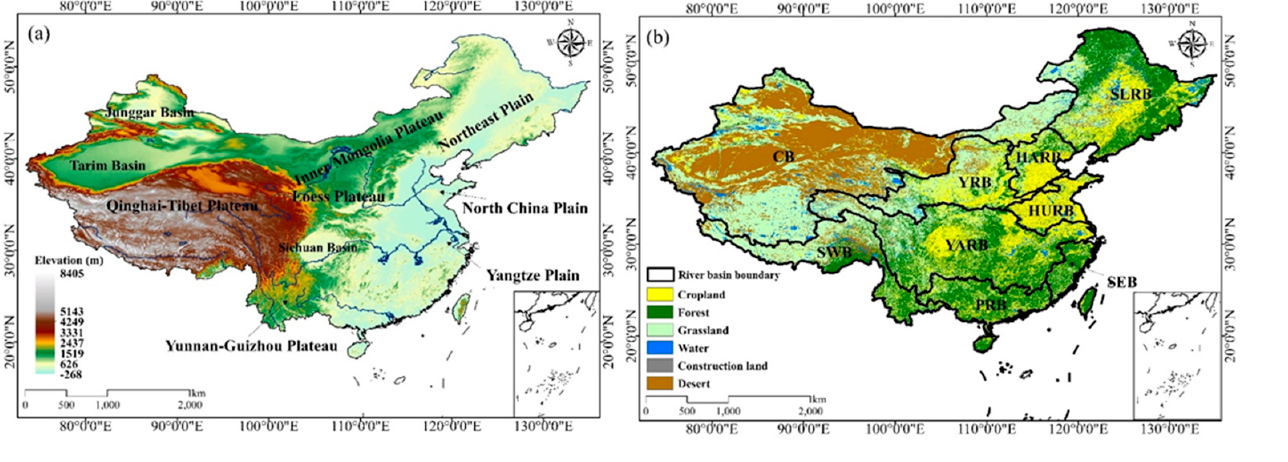
Figure 1. Geographic zones ( a ) and main river basins ( b ) in China. The main river basins include the Songhua and Liaohe River Basins (SLRB), Haihe River Basin (HARB), Huaihe River Basin (HURB), Yellow River Basin (YRB), Yangtze River Basin (YARB), Pearl River Basin (PRB), Southeast Basin (SEB), Southwest Basin (SWB), and Continental Basin (CB).